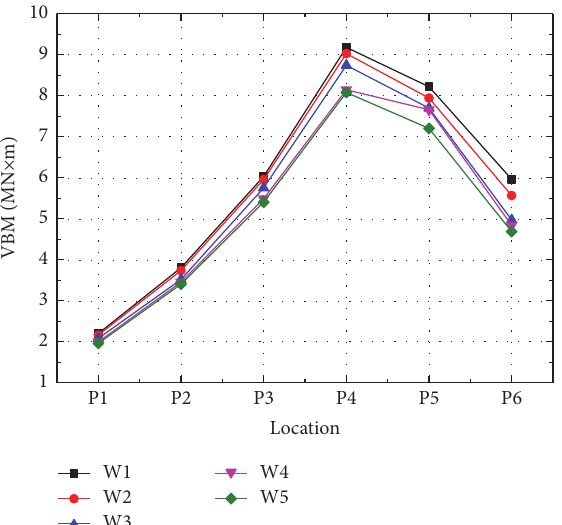
Figure 22: Longitudinal distribution of VBM in beam sea.